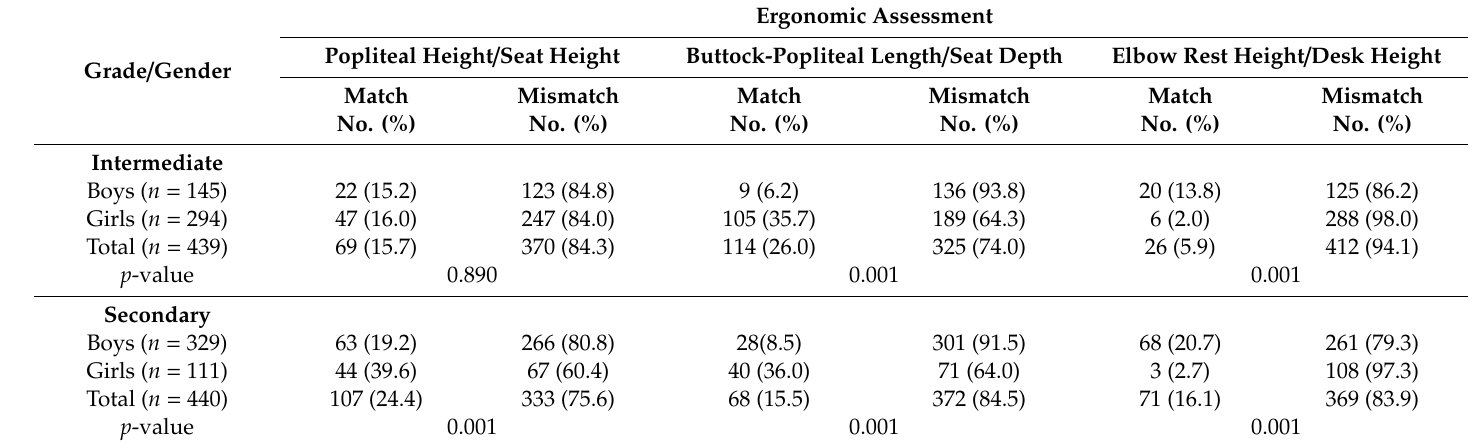
Table 2. Students- furniture match / mismatch percentages by gender and grade level ( n =